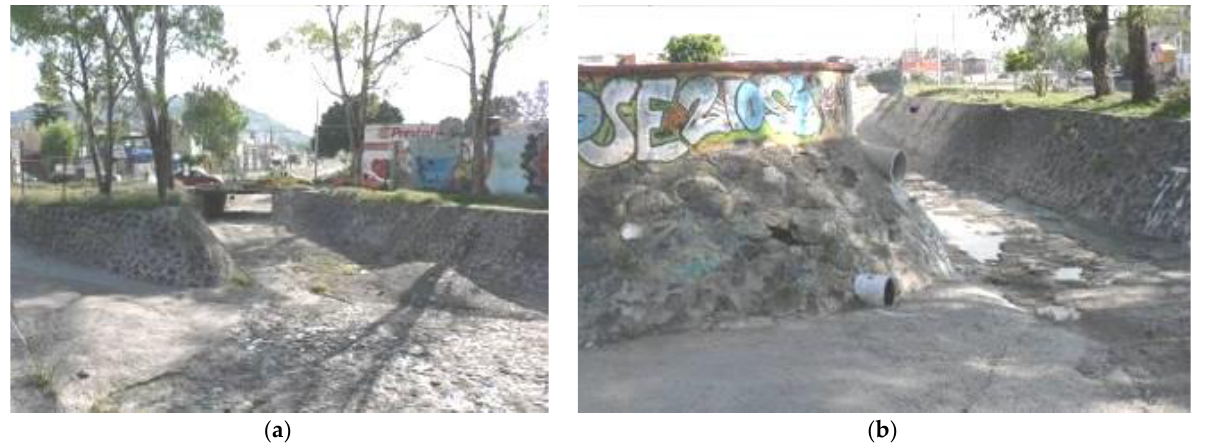
( b ) Figure 4. Evidence of traces. ( a ) Water marks on the wall of houses; ( b ) sediment marks on bridge piles. 5.3. Principle of Exchange Some evidence of flooding is found in the river, in the buildings and in the func- tional components of the river. In this case, urban debris was found. In Figure 5a, urban debris such as tree branches and trash deposited in a storm drain overpass. In Figure 5b, debris on the branches of a downed tree allows us to determine the possible height of the water level reached.